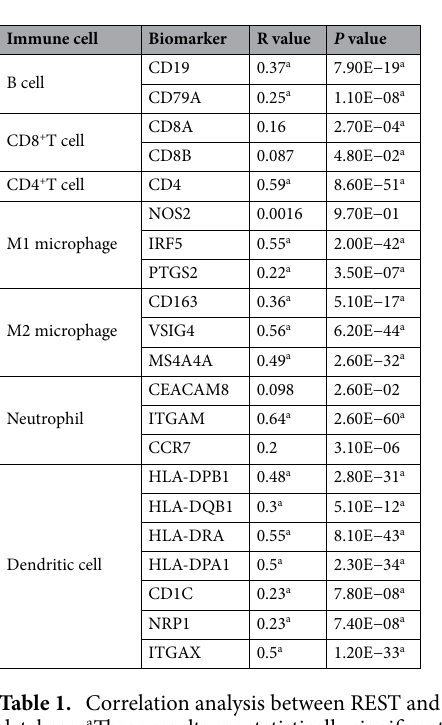
Table 1. Correlation analysis between REST and biomarkers of immune cells in glioma determined by GEPIA database. a These results are statistically significant.